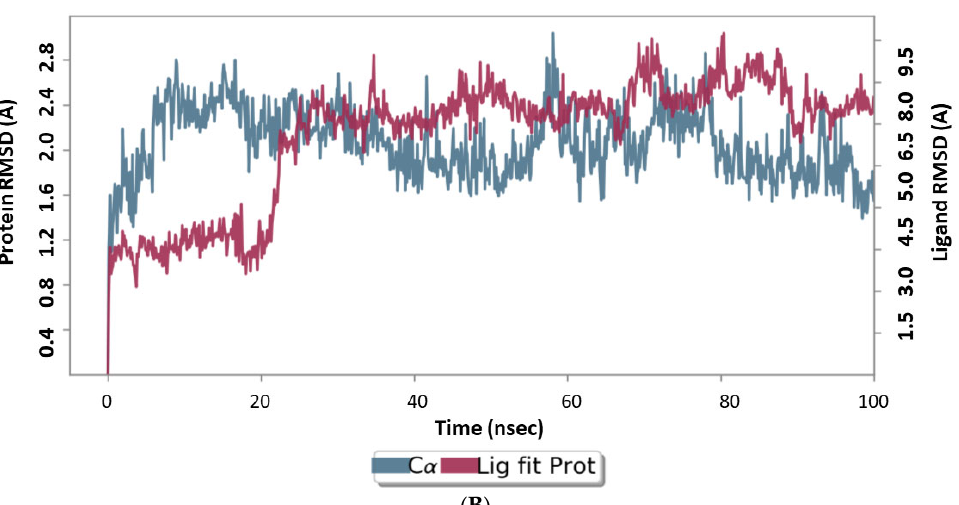
Figure 8. Results of MD of Main protease target (PDB ID: 5R80). ( A ) RMSD of the complex main protease (PDB ID: 5R80) complexed with Z18197050; ( B ) RMSD of the complex Main protease (PDB ID: 5R80) complexed with 6i . RMSD values are calculated from run of the average change in displacement of a selection of atoms for a particular frame with respect to a reference frame trajectory.